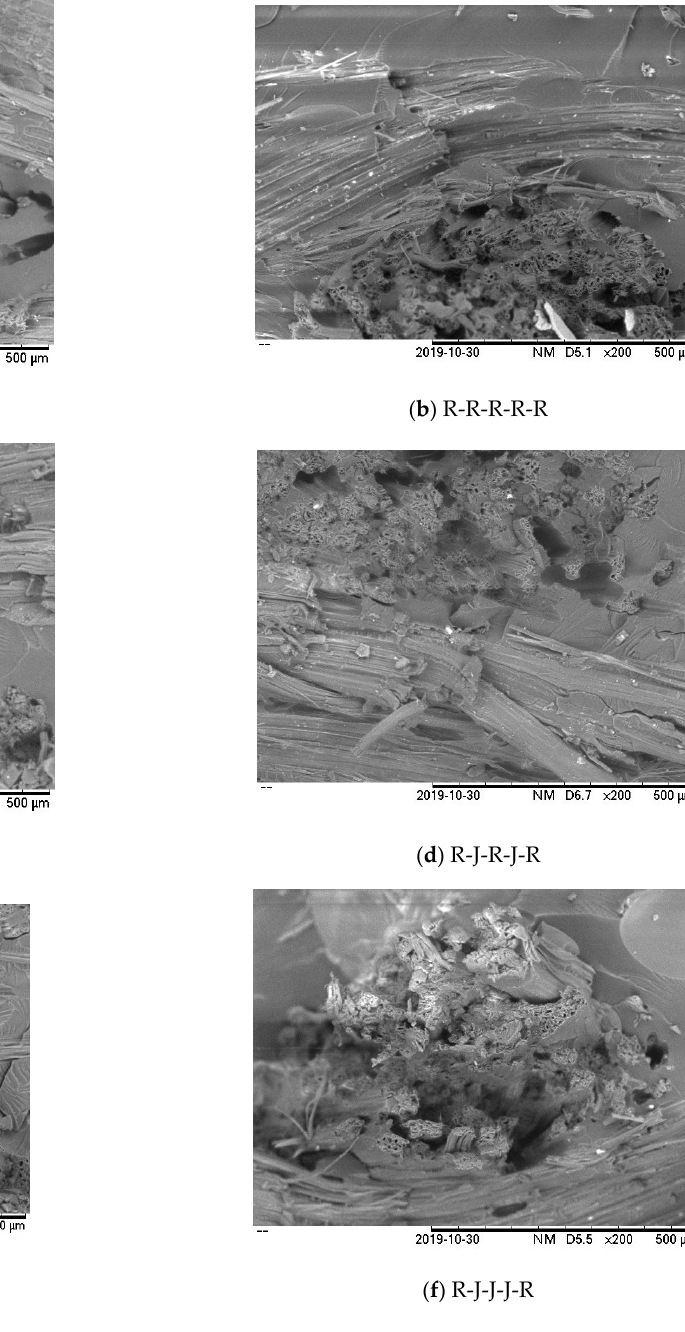
Figure 11. SEM analysis on the tensile surface fracture (magnification 200 × ) of single and hybrid jute–ramie composites ( a – f